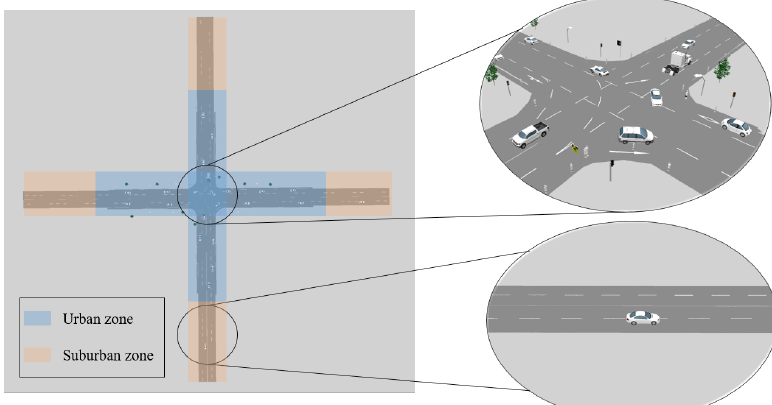
Figure 4. The considered intersection simulated in